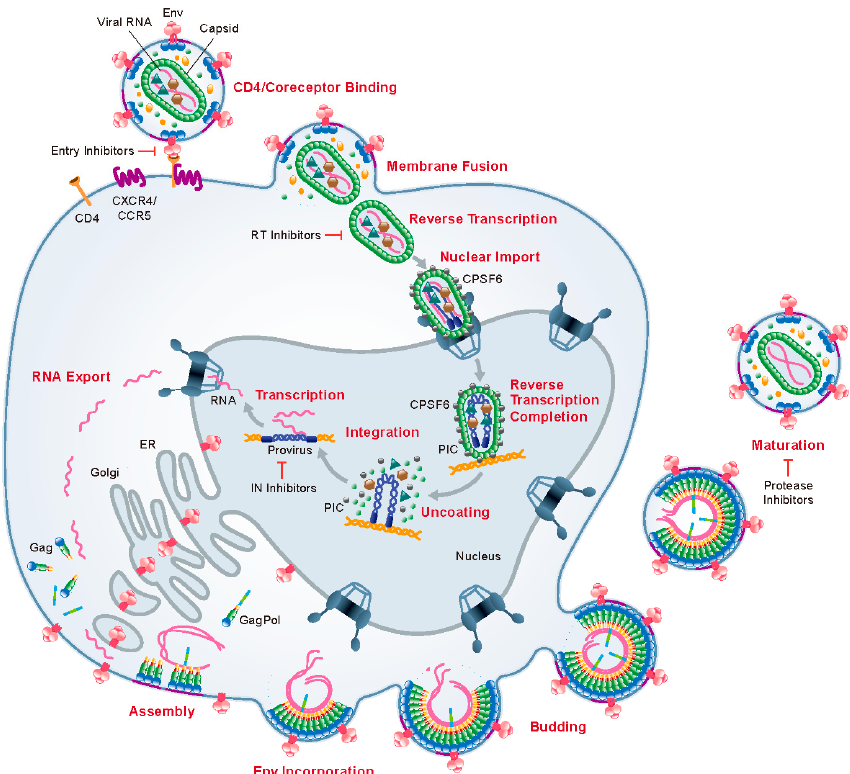
Figure 1. HIV-1 replication cycle. Mature virions attach to the surface of a target cell via an interaction between the gp120 subunits of viral Env trimers and host CD4 and coreceptor (CCR5 or CXCR4). The gp41 subunits of Env then trigger the fusion of the viral and host cell membranes and the capsid is deposited into the cytosol. Reverse transcription proceeds as the capsid traffics to the nuclear envelope where it is imported into the nucleus in an intact or nearly intact state. Reverse transcription is completed in the nucleus, followed by uncoating of the capsid and integration of the viral DNA into the host genome. Transcription of the proviral DNA leads to the expression of HIV-1 proteins including the Gag and GagPol polyproteins. These structural proteins are targeted to the inner leaflet of the plasma membrane where they form hexameric subunits that assemble into a curved, membrane-associated lattice. Viral genomic RNA dimers are recruited to these sites of assembly and Env trimers are incorporated into the budding particles. Membrane scission and particle release are facilitated by endosomal sorting complexes required for transport (ESCRT) recruitment mediated by the Gag-p6 domain. Concomitant with particle release, protease (PR), which is packaged into virions as part of the GagPol polyprotein, cleaves the Gag and GagPol polyproteins into their individual mature proteins. The newly liberated CA monomers then form hexamers and pentamers that assemble into the mature capsid, resulting in a mature, infectious particle. The site of action of FDA-approved antiretroviral drugs (ARVs) is indicated. Additional details are provided in the main text. Viral proteins are not shown to scale.